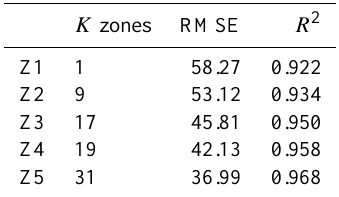
Table 2. Goodness of fit